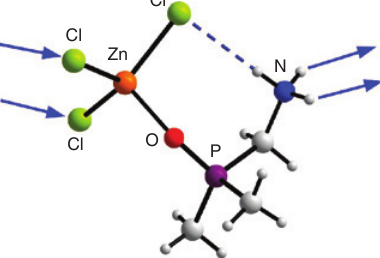
is shown with the intramo- Figure 1: The title complex dpma HZnCl 3 lecular hydrogen bond. Arrows indicate the preferable directions for further hydrogen-bonding interactions of this supramolecular tecton. The graph-set descriptor for the intramolecular hydrogen bond is S 1 (7) (Grell et al., 1